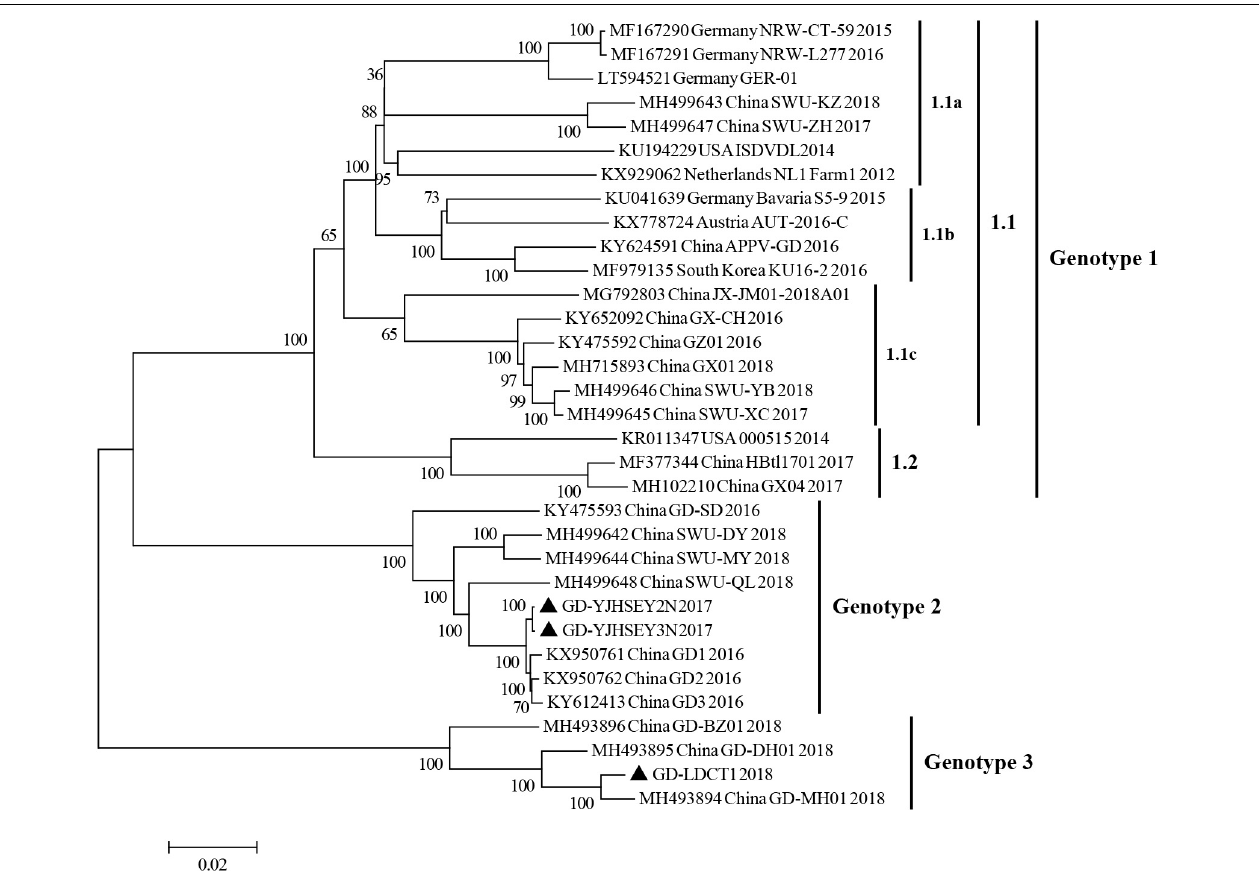
FIGURE 2 | Phylogenetic trees based on the sequences encoding the polyprotein of APPV. Three complete ORF sequences obtained in this study are marked with black triangles. Published sequences, including 30 complete APPV sequences, were downloaded from the GenBank database. MEGA 6.0 software was used to construct the neighbor-joining (NJ) phylogenetic trees using a p-distance method with a bootstrap of 1,000